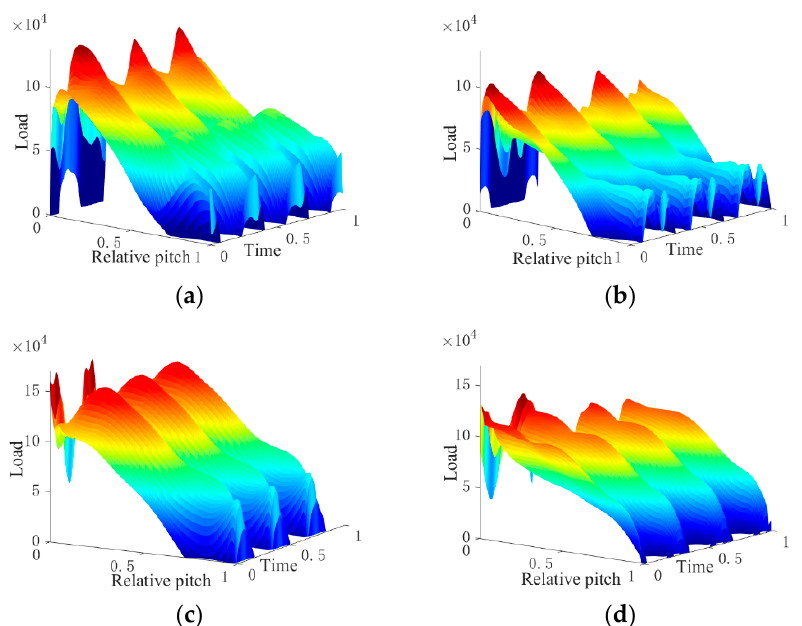
Figure 14. Rotor blade load fluctuation at the 50% and 95% height of the two models: ( a ) base model at 50% of the blade height; ( b ) SSGV model at 50% of the blade height; ( c ) base model at 95% of the blade height; ( d ) SSGV model at 95% of the blade height.